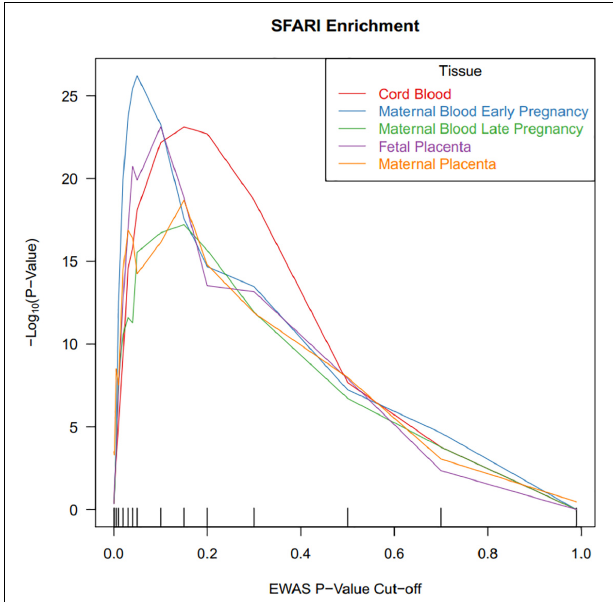
FIGURE 3 | CpG sites associated with ASD status in cord blood are highly enriched for ASD risk genes. DNA methylation sites were tested for association with ASD status, and the x -axis illustrates P -value criteria selecting DNA methylation sites based on these association tests. The DNA methylation sites were mapped to genes and these genes were tested for enrichment in ASD risk genes. The y -axis demonstrates the –log 10 (P- value) for these enrichment tests. Line colors are based on the tissue measured for DNA